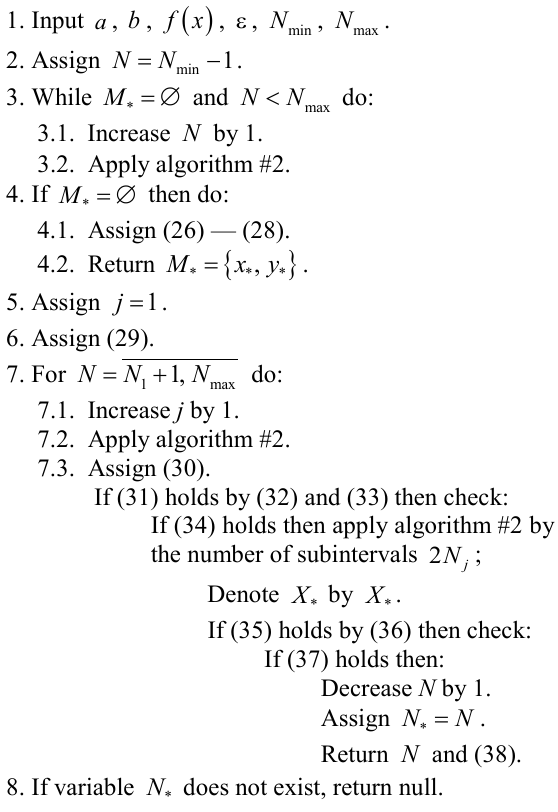
algorithm #2 returns this number of approximate local minimum points which differ from the true local minimum points at most by ε